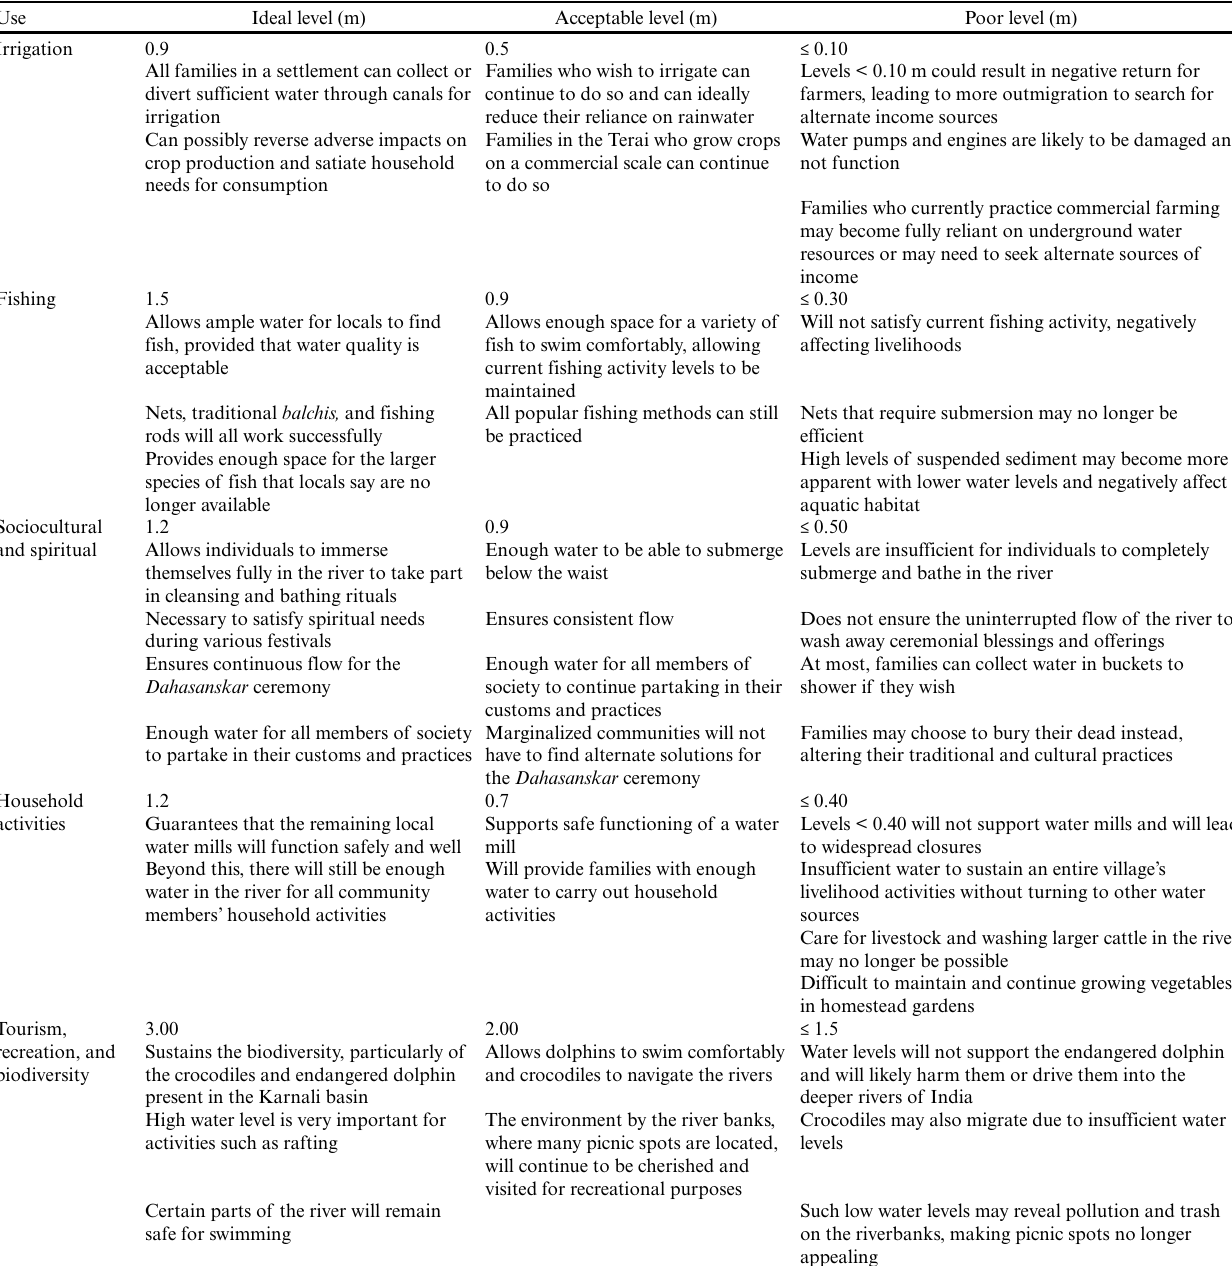
Table 2. Water depth indicators for livelihood requirements from